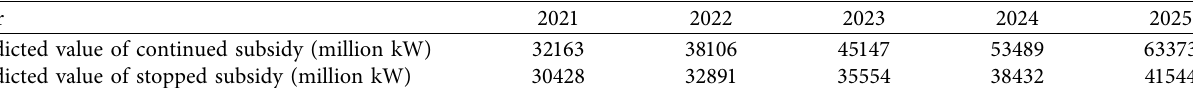
Table 7: Predicted value of wind power installed capacity from